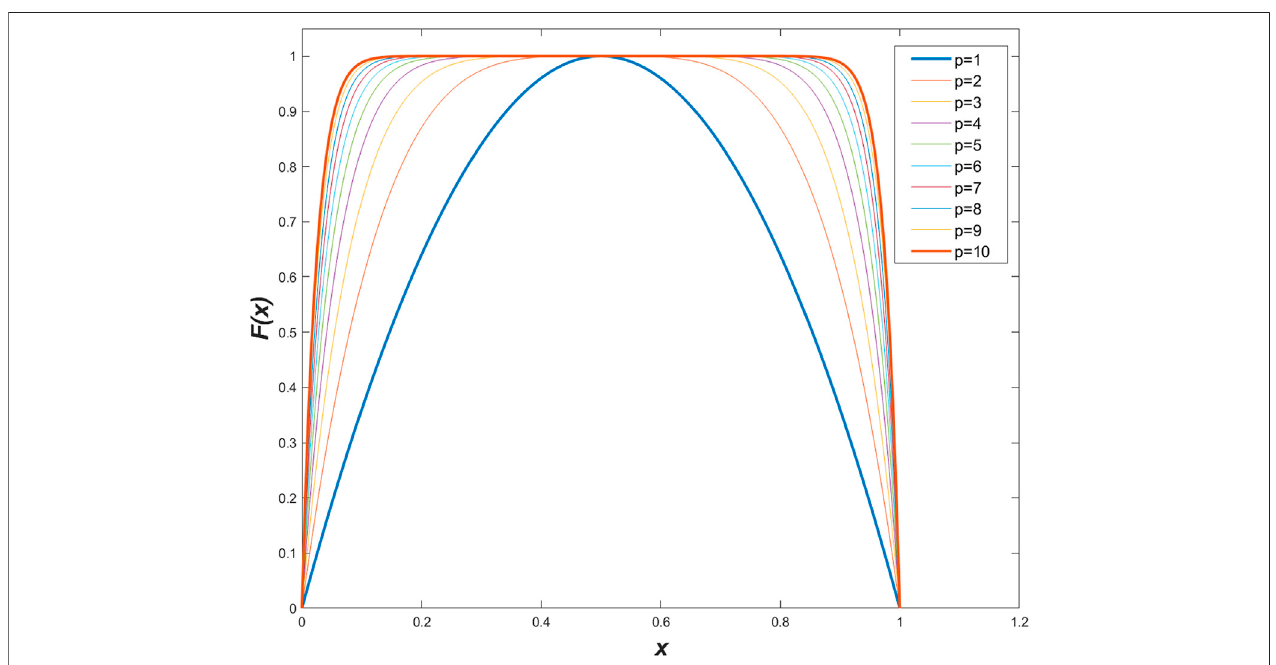
FIGURE 2 | Variation curve of window function F ( x ) with x for different values of p .